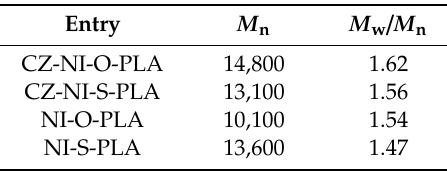
Table 1. Polylactide molecular weight and molecular weight